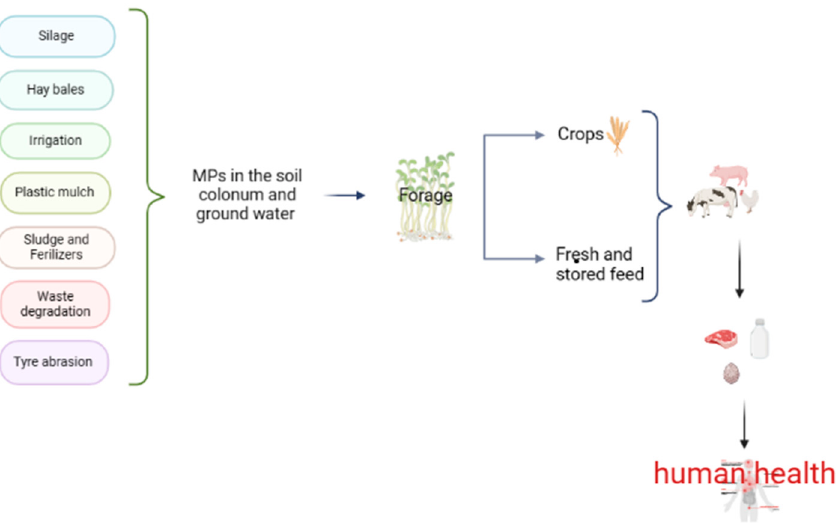
Figure 1. A schematic diagram of the sources and fate of plastic particles in the soil. Silage covers, strings of the attached when baling hay, irrigation with water contaminated by MPs, plastic mulch, sludge and fertilizers, municipal waste degradation, tire abrasion and roadside litter affect the structure, fertility, nutrients and microbes of the soil. Land is used to produce feed for food-producing animals, which can be consumed fresh or stored. All of these sources increase the risk to human health through the ingestion of MPs from milk, meat and eggs.